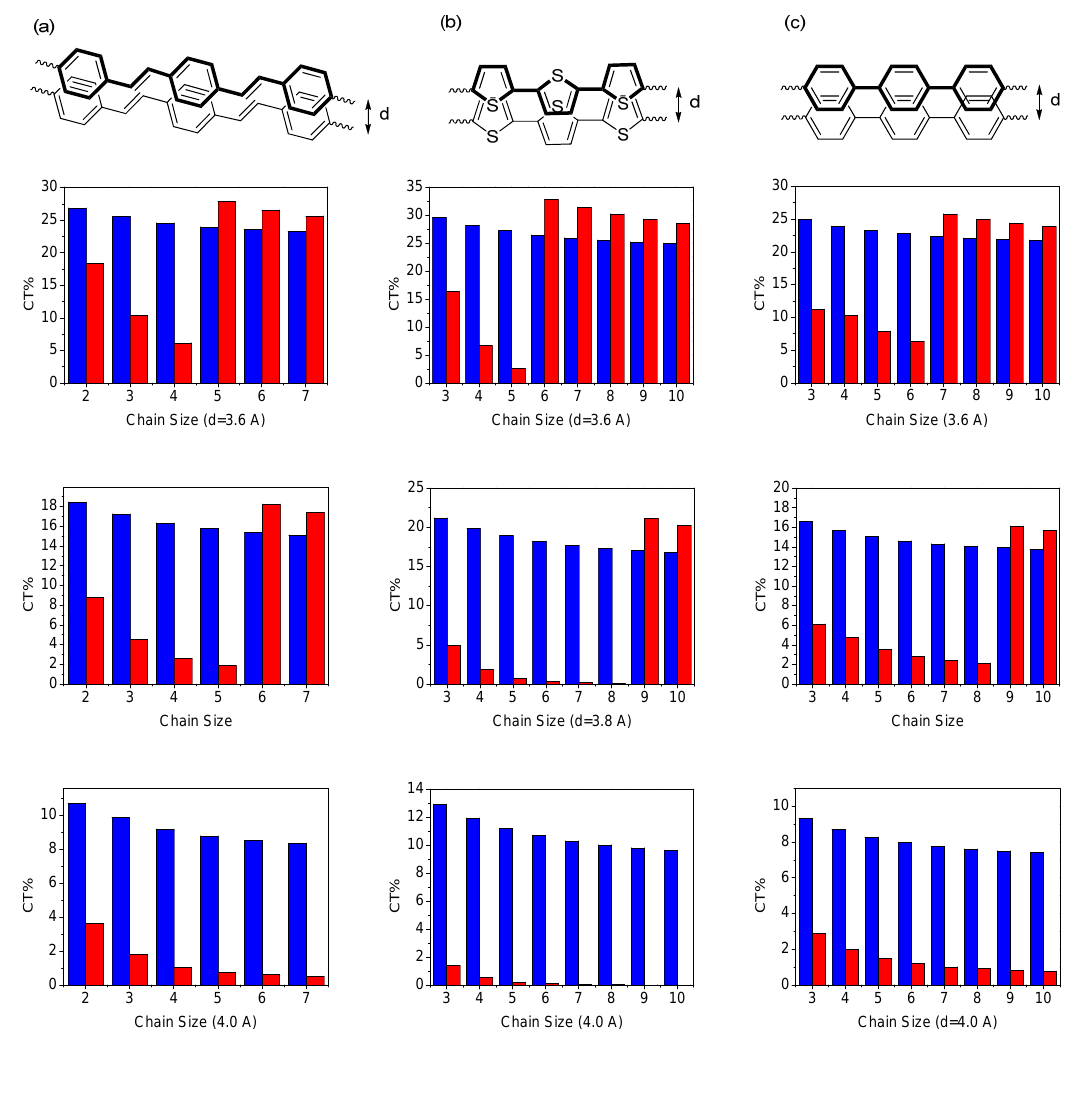
Figure 6. Dependence of the CT wave function (percentage) of lowest excited-state (blue) and second excited-state (red) for (a) PV size, with interchain distance d = 3.6 Å (upper), 3.8 Å (middle), 4.0 Å (lower), calculated by the CM